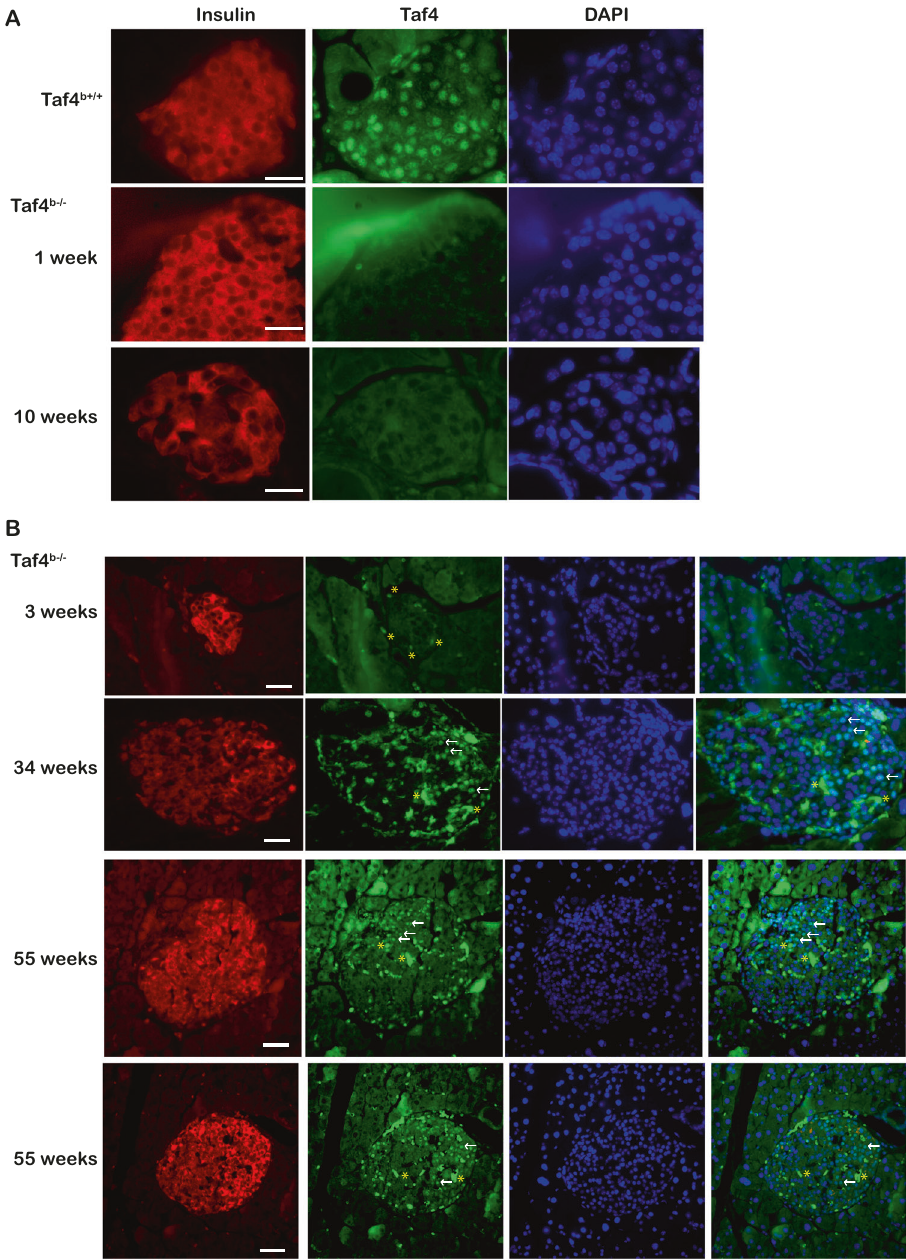
Fig. 1 Inactivation of Taf4 in beta cells. A Immunostaining of Langerhans islets from mice with the indicated genotypes for Taf4 or insulin as indicated. The number of weeks after Tam injection are indicated. B Immunostaining of Langerhans islets as above but with the addition of the Taf4-DAPI merge. Representative Taf4-positive nuclei at 34 and 55 weeks are indicated by arrows, not to be confounded with the stronger non-speci fi c staining indicated by *. Scale bar = 100 μ